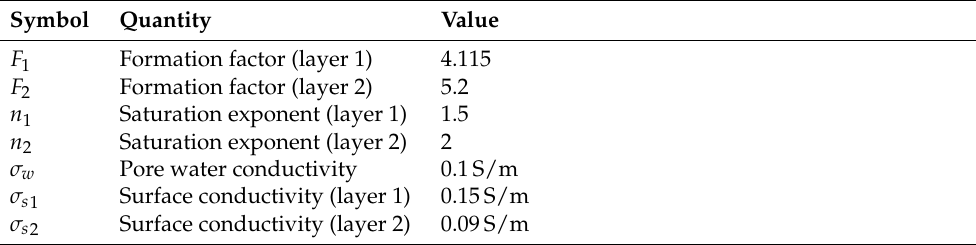
Table 2. Petro-physical parameters for both layers used for the synthetic study and the field data analysis.